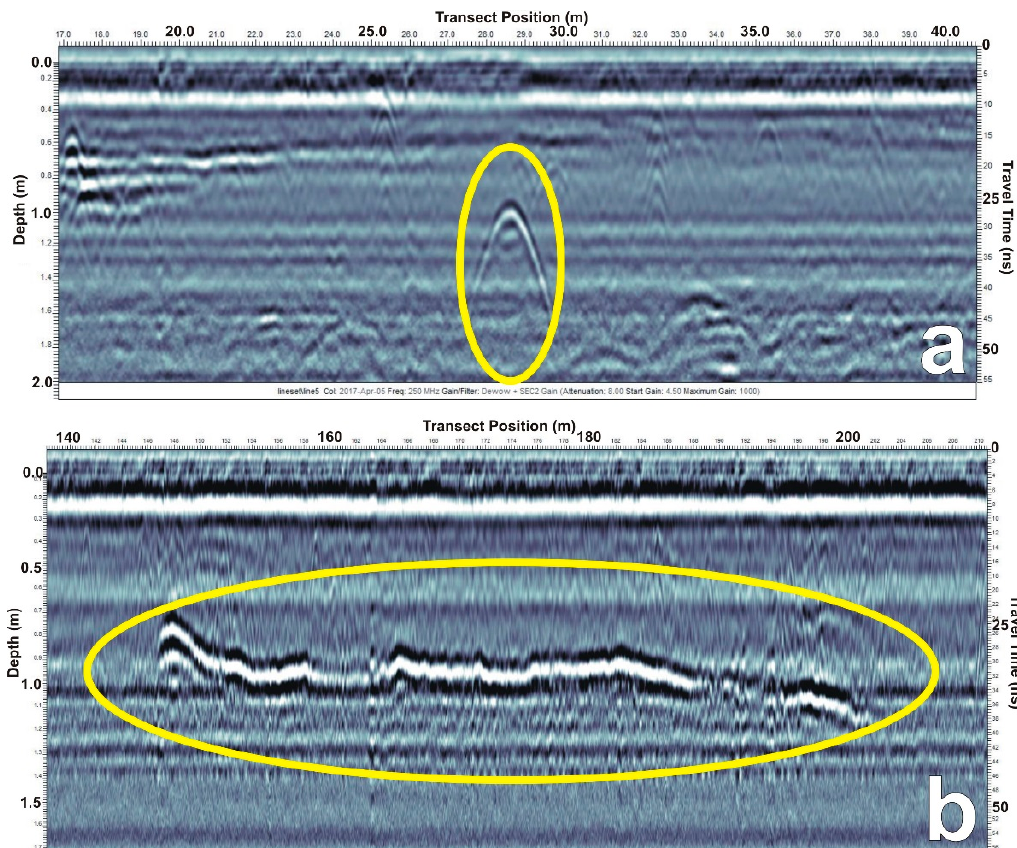
Figure 5. GPR profile drainage pipe responses; ( a ) horizontally compressed upside down U-shaped feature (i.e., reflection hyperbola) within yellow line oval results from the GPR transect being oriented perpendicular to drain line directional trend (from Site 1); ( b ) the banded linear feature within the yellow line oval results from the GPR transect being oriented the over top and along the trend of a drain line (from Site 3).